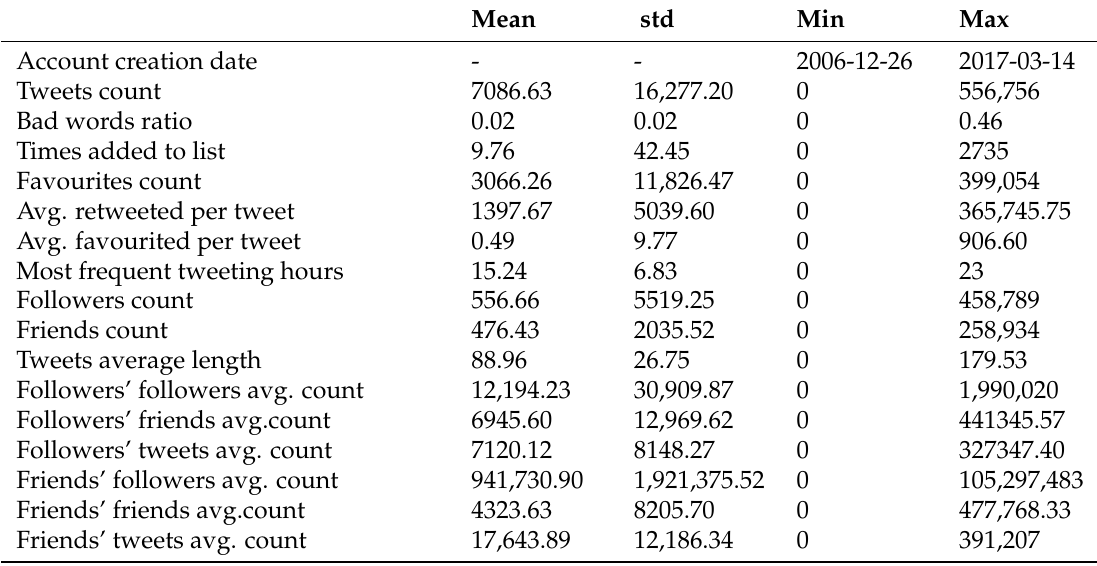
Table 2. Twitter features